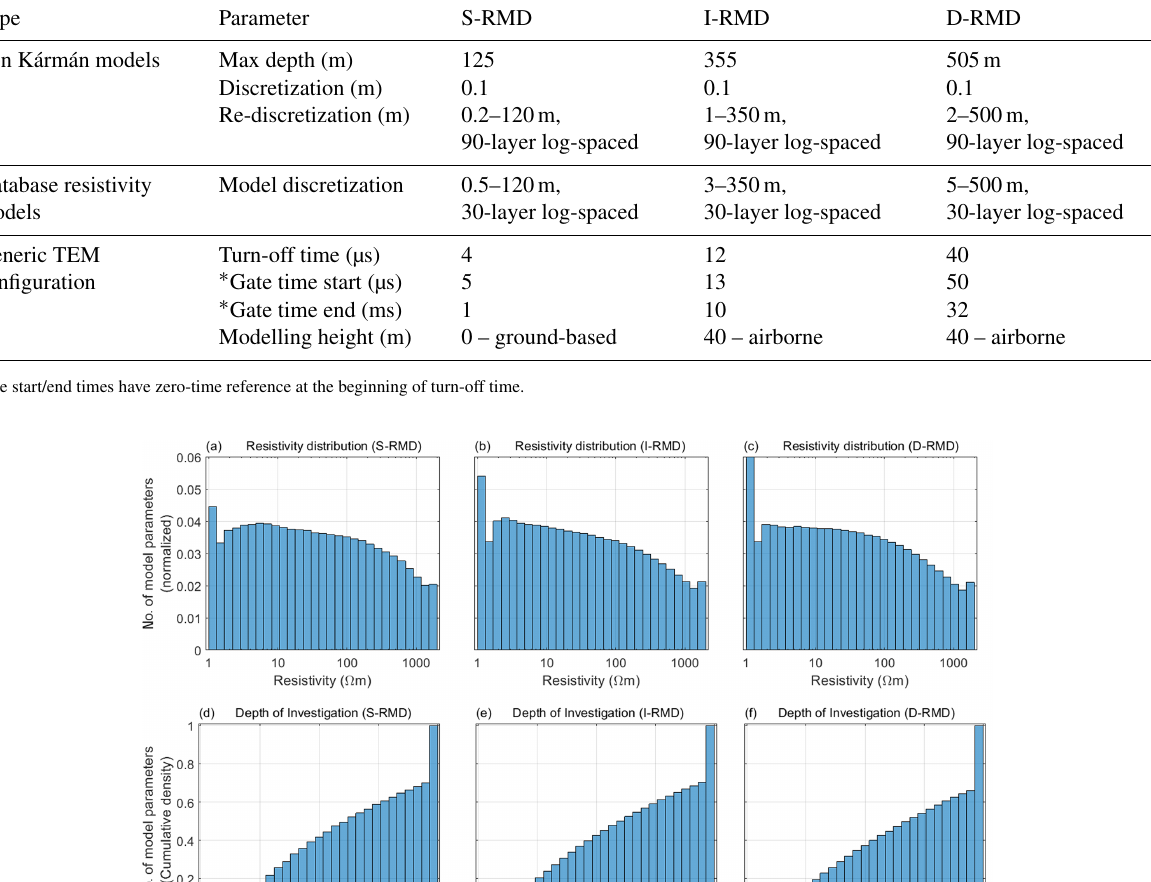
Table 3. Model discretization and key specifications of the generic TEM systems for three resistivity model databases. The generic TEM systems are all central loop configurations.